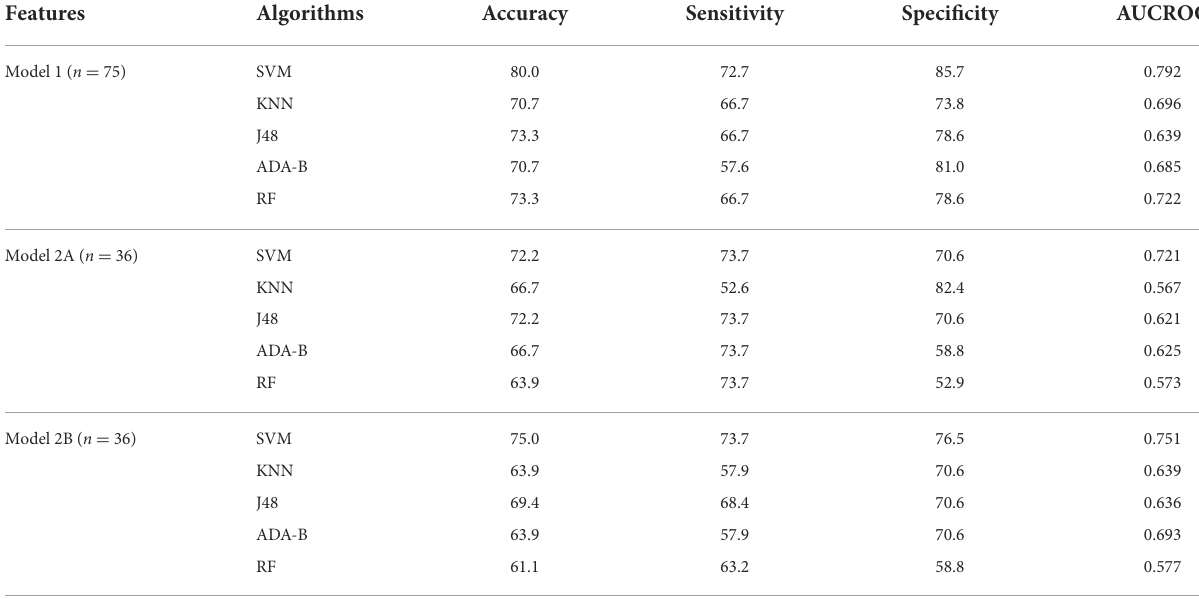
TABLE 4 Evaluation metrics per each algorithm and per each model, where Model 1 included clinical and gait features during the COG task, Model 2 included PET features (Model 2A included cortical and subcortical regions, Model 2B included only cortical regions), and the top five features of Model